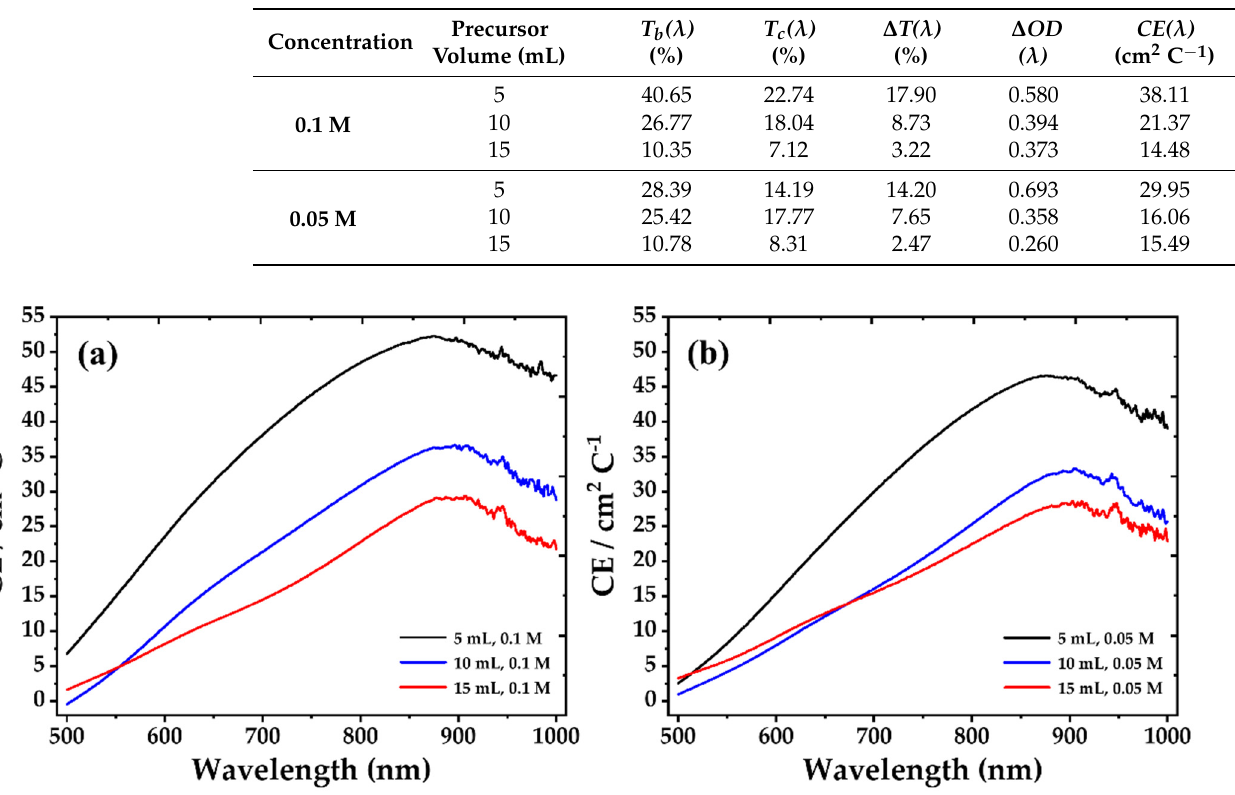
Figure 4. Coloration efficiency comparison as a function of the measured wavelengths: ( a ) 5, 10 and 15 mL with 0.1 M; ( b ) 5, 10 and 15 mL with 0.05 M.